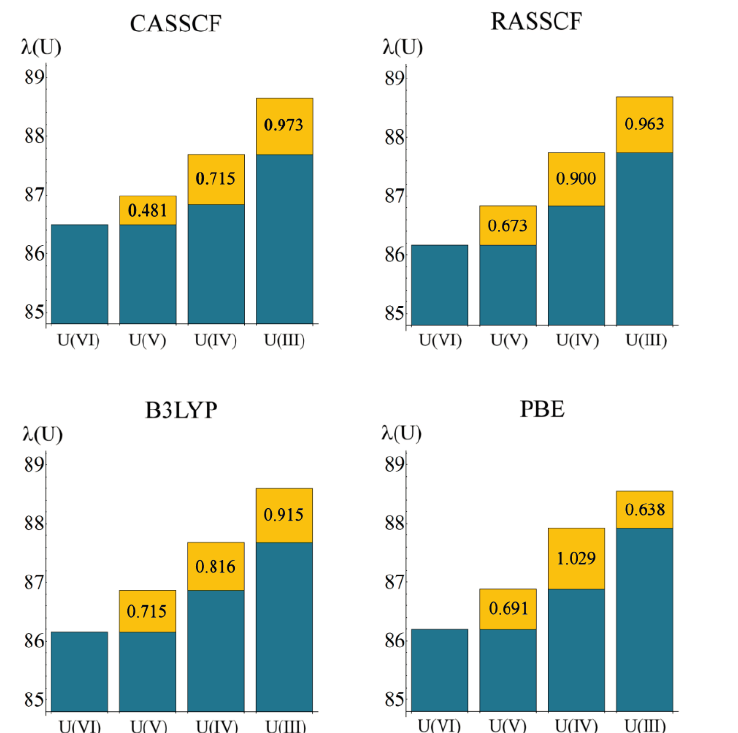
Figure 4. Localisation index as a function of oxidation state, calculated at all levels of theory. Values in yellow boxes indicate increase in electron localisation as oxidation state is lowered. All values are in atomic